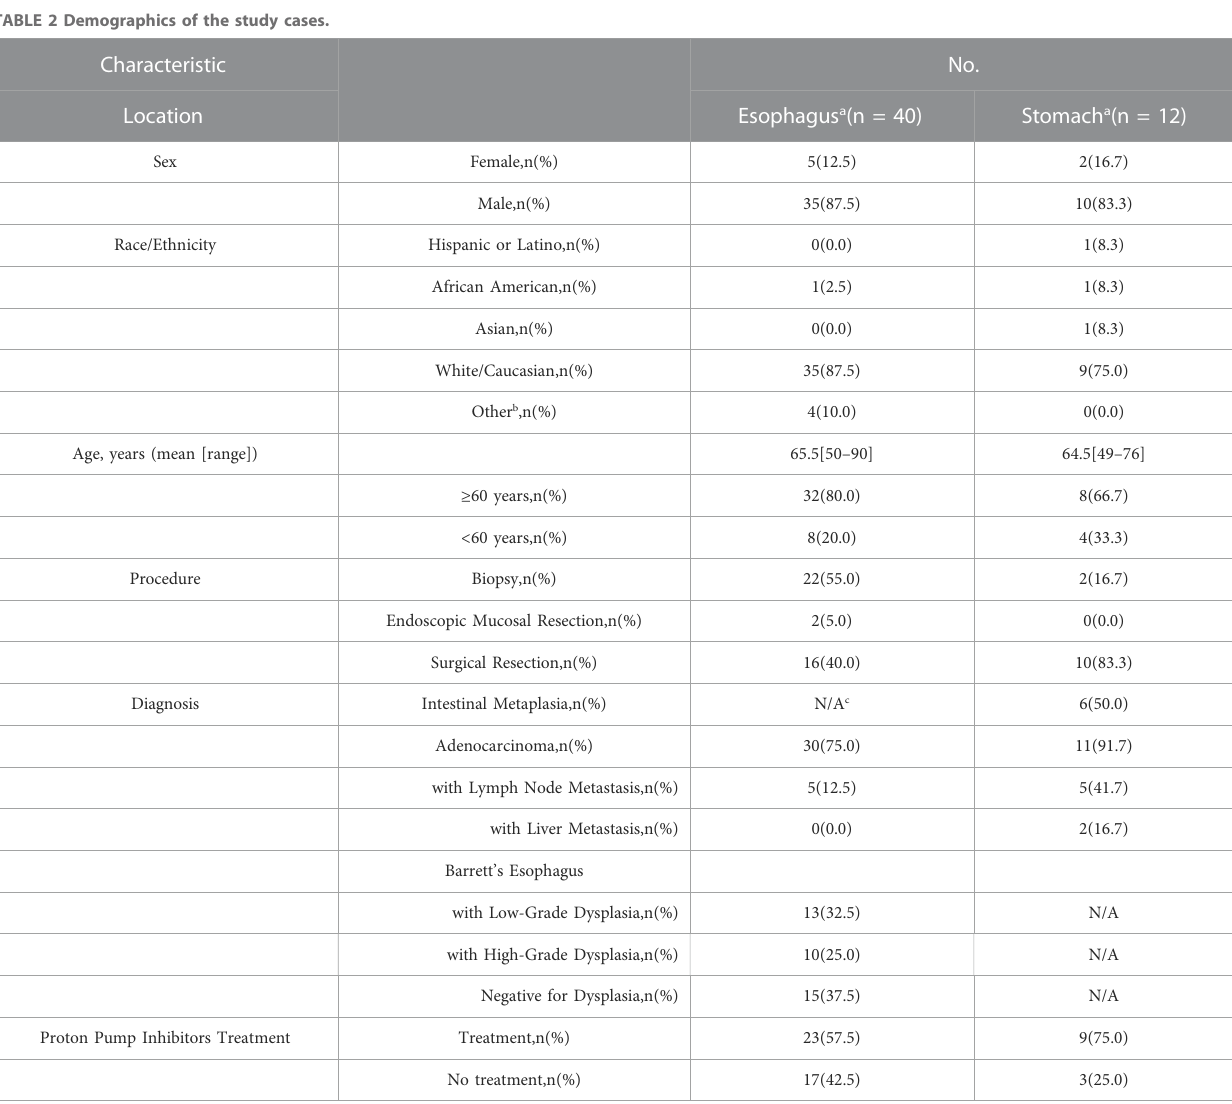
TABLE 2 Demographics of the study cases.